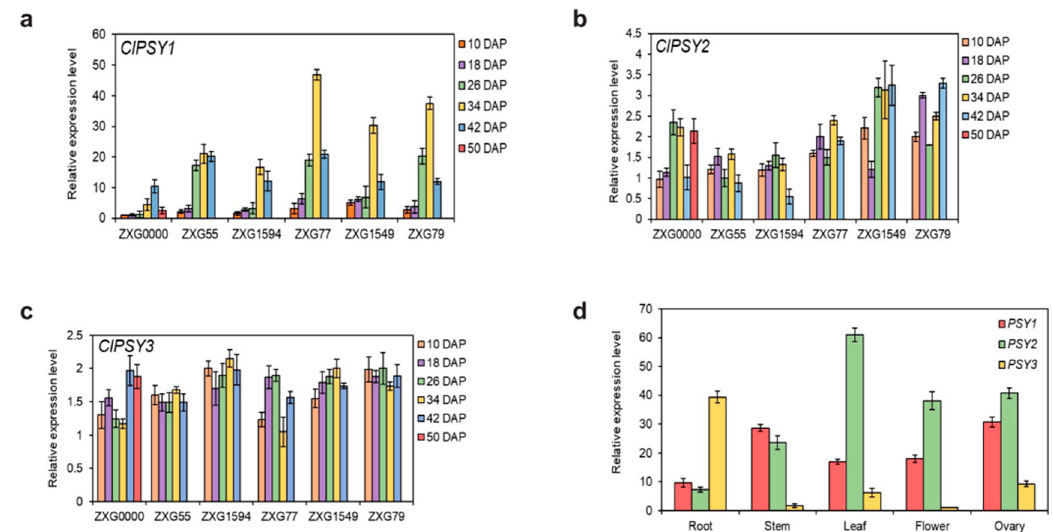
Figure 3. Expression of ClPSY members in different watermelon accessions and organs. ( a – c ) Tran- scription levels of ClPSY1 , ClPSY2 and ClPSY3 in six watermelon varieties with different fruit colors at six time points (10, 18, 26, 34, 42, 50 days after pollination) during fruit development. Additionally, the fruit sample ‘ZXG0000’ at 10 DAP was used for calibration. The bars represent the means ± SD ( n = 3). ( d ) Expression patterns of the three ClPSY genes in different organs. Total RNA samples were isolated from various watermelon organs, including 4-week seedling roots, stems, leaves, flowers and ovaries. The y-axis shows the relative expression levels of the three ClPSY genes in different tissues compared to ClPSY3 in flowers. The bars represent the means ± SD ( n = 3).